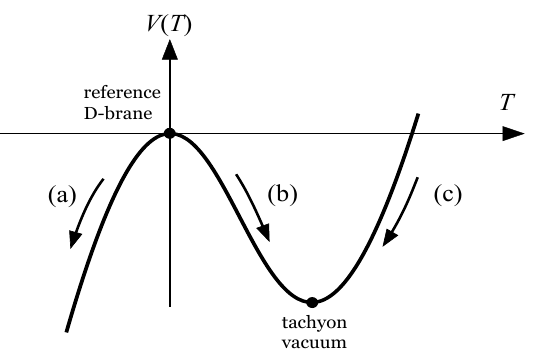
Figure 4 . The light-like rolling tachyon solution can potentially describe three distinct time de- pendent backgrounds. Starting from the original D-brane con(cid:12)guration, case (a) represents the tachyon rolling towards negative values, where the e(cid:11)ective potential is unbounded from below, and case (b) represents falling towards the tachyon vacuum. Case (c) represents rolling towards the tachyon vacuum from the \other side" on the tachyon e(cid:11)ective potential. the solution ends, but analytic continuation leads to a di(cid:11)erent solution which rolls from + 1 at (cid:12)nite time down to the local minimum at (cid:30) = 1 in the in(cid:12)nite future, as in case (c). One might guess that something similar happens for the tachyon in string (cid:12)eld theory. But this cannot be correct. The singularity in the evolution of (cid:30) ( x ) for (cid:21) < 0 is possible since the early time expansion in powers of e (cid:12)x + has (cid:12)nite radius of convergence. But the early time expansion in string (cid:12)eld theory has in(cid:12)nite radius of convergence. So a (cid:12)nite time singularity in the string (cid:12)eld theory solution is not